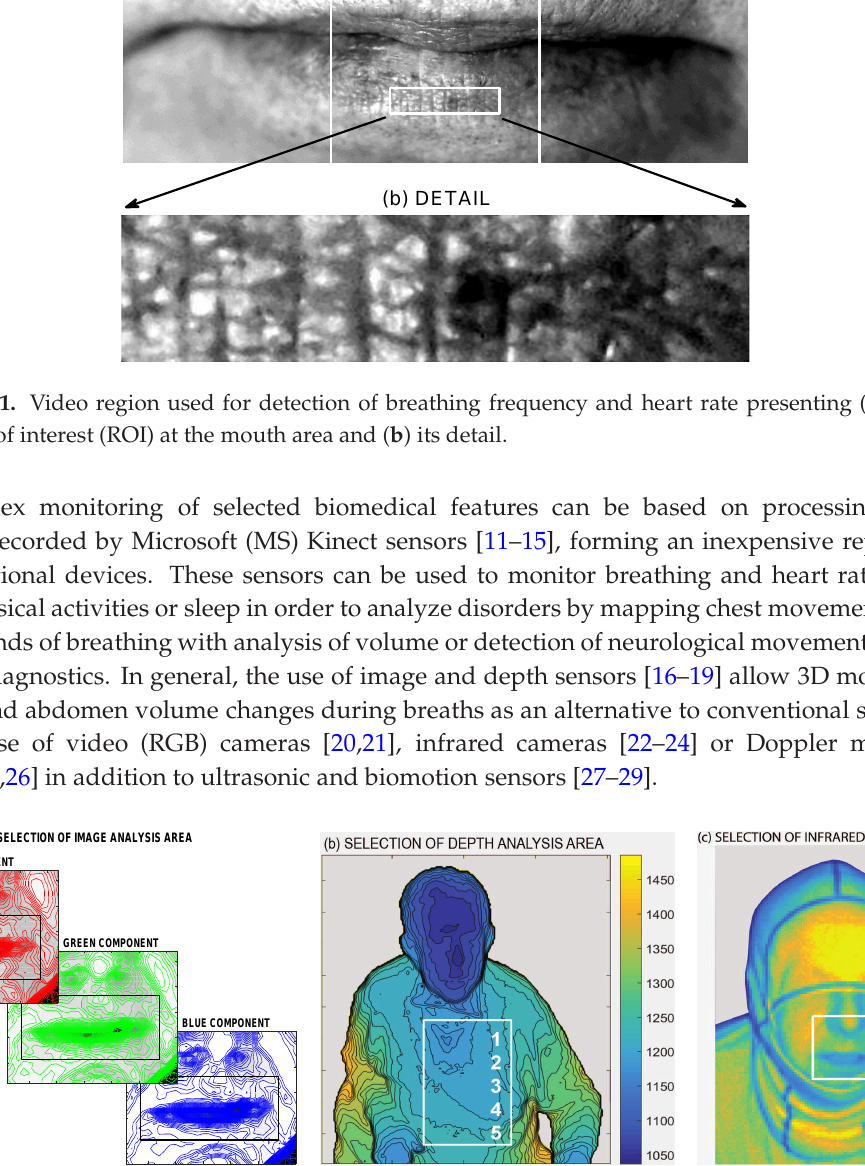
Figure 2. Data acquired by Microsoft (MS) Kinect presenting ( a ) red, green and blue image components; ( b ) depth sensor data; and ( c ) infrared data of a selected video frame with the area used for the time evolution of the object